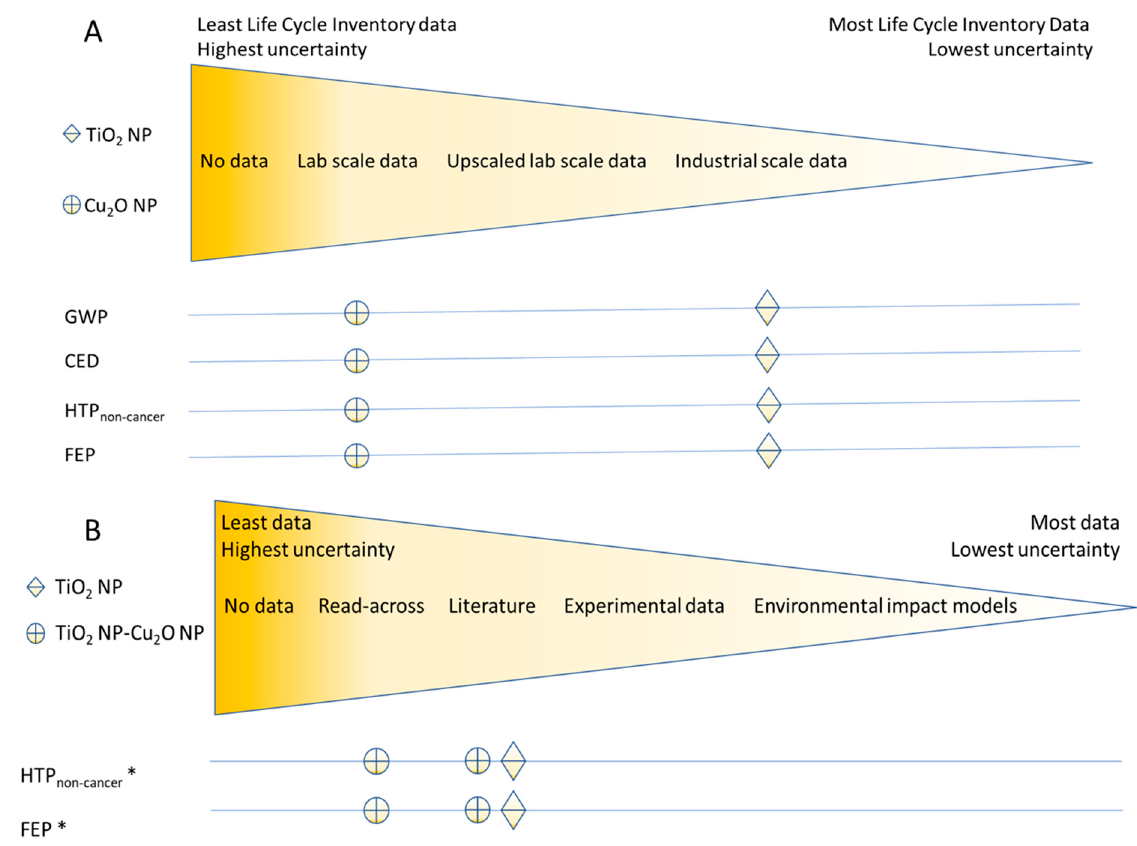
Figure 4. Uncertainty heat map for the different data sources: ( A ) life cycle inventory data scale and environmental impact results; ( B ) data sources for characterization factors and environmental impact results, * environmental impacts due to nano ‐ forms.